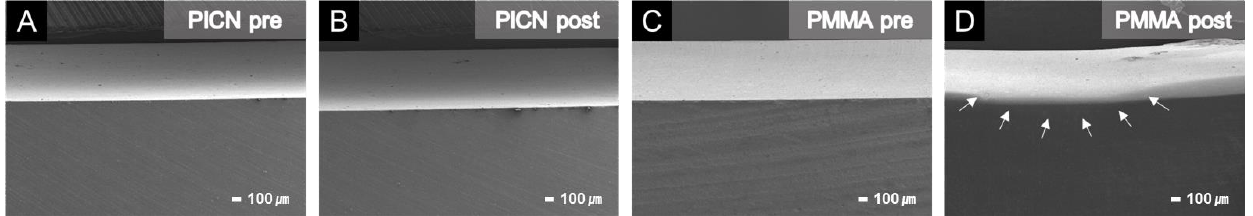
Figure 8. Surface conditions of the specimens, pre- and post-artificial toothbrushing, in SEM images at 1000-times magnification. Surface changes occurred after artificial toothbrushing, with the degree of difference depending on the material. The Rz change in DCF appeared to be the largest, and shallow streaks appeared on the surface of the PMMA specimen. The PICN surface was almost unchanged. ( A ) PMMA pre, ( B ) DFC pre, ( C ) PICN pre, ( D ) PMMA post, ( E ) DFC post, and ( F ) PICN post.